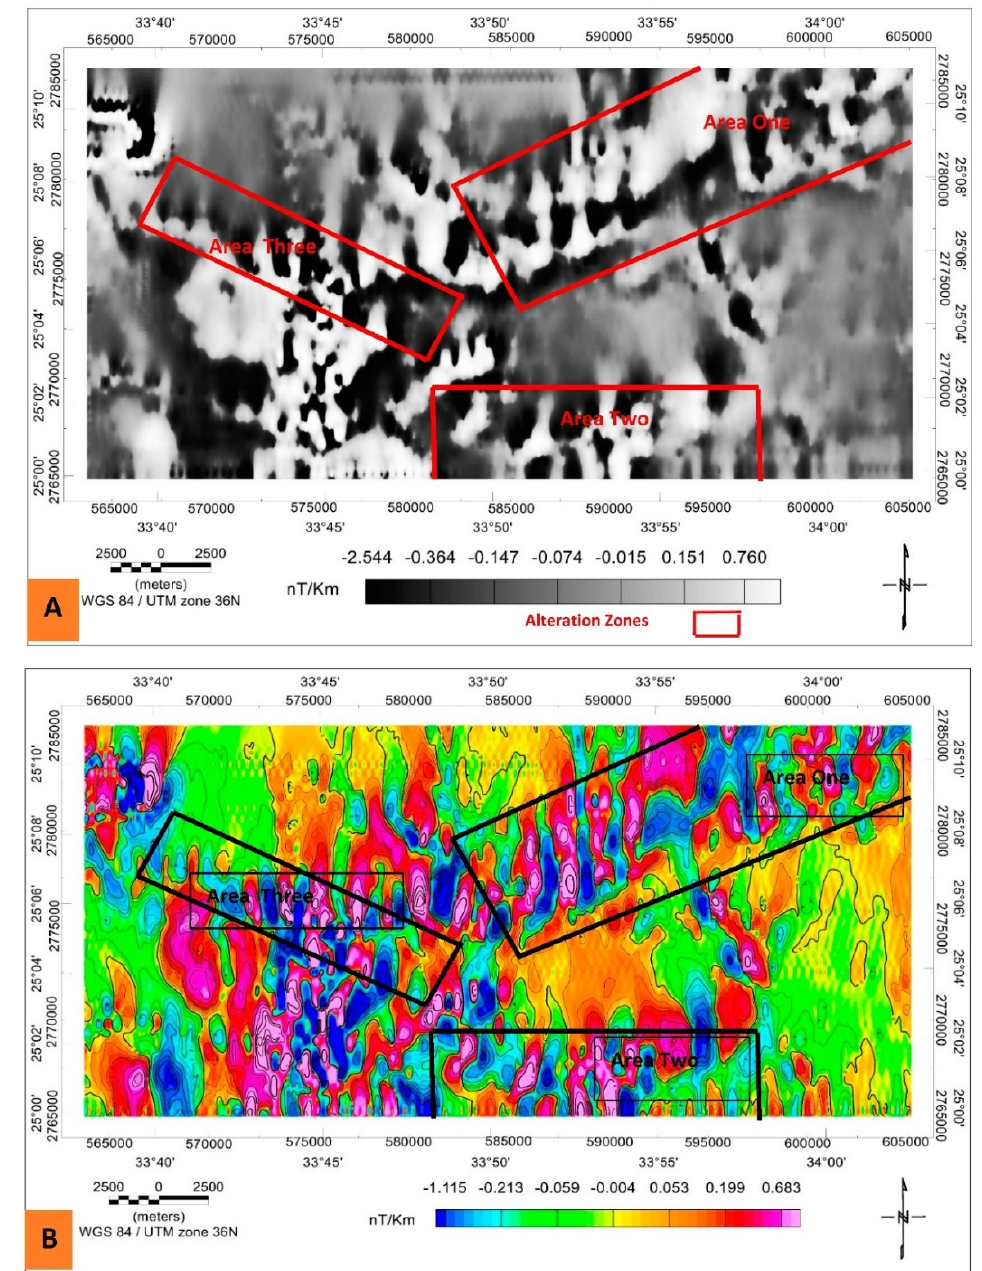
Figure 6. The FVD map ( A ), and the THG map ( B ) of the research area. The horizontal gradient derivative method is used to identify the borders that separate the common rock units in the area, where steep gradients occur across near-vertical contacts between units of variable magnetic characteristics [31,32]. The local peaks can be used to determine the location of the steepest gradients. The anomalies range in magnitude from 0.683 to − 1.115 nT/Km (Figure 6B). Most of the anomalies run in the N–S direction